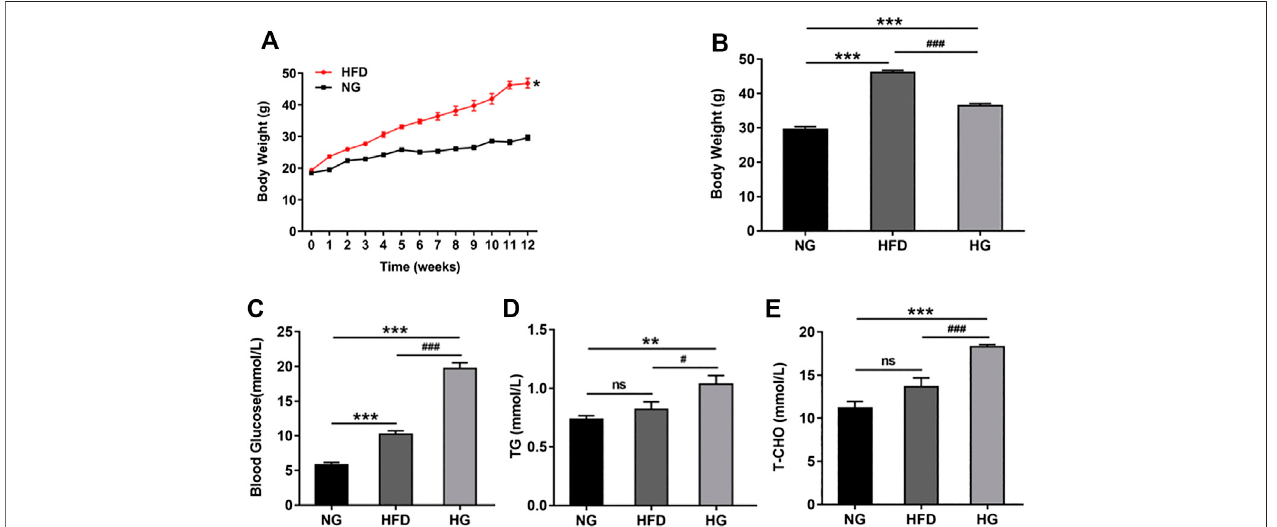
FIGURE 1 | A type 2 diabetic model was established by a high-fat diet (HFD) and STZ injection (A) The changes of body weight in mice during the process of HFD (n (cid:2) 10). (B) Body weight before and after STZ injection (n (cid:2) 10). (C – E) The effects of HFD-STZ on the levels of fasting blood glucose, serum triglycerides, and total cholesterol, in mice (n (cid:2) 6). Data are presented as means ± SEM. * p < 0.05, ** p < 0.01, *** p < 0.001 vs. normal glucose (NG) group; # p < 0.05, ### p < 0.001 vs. HFD group.